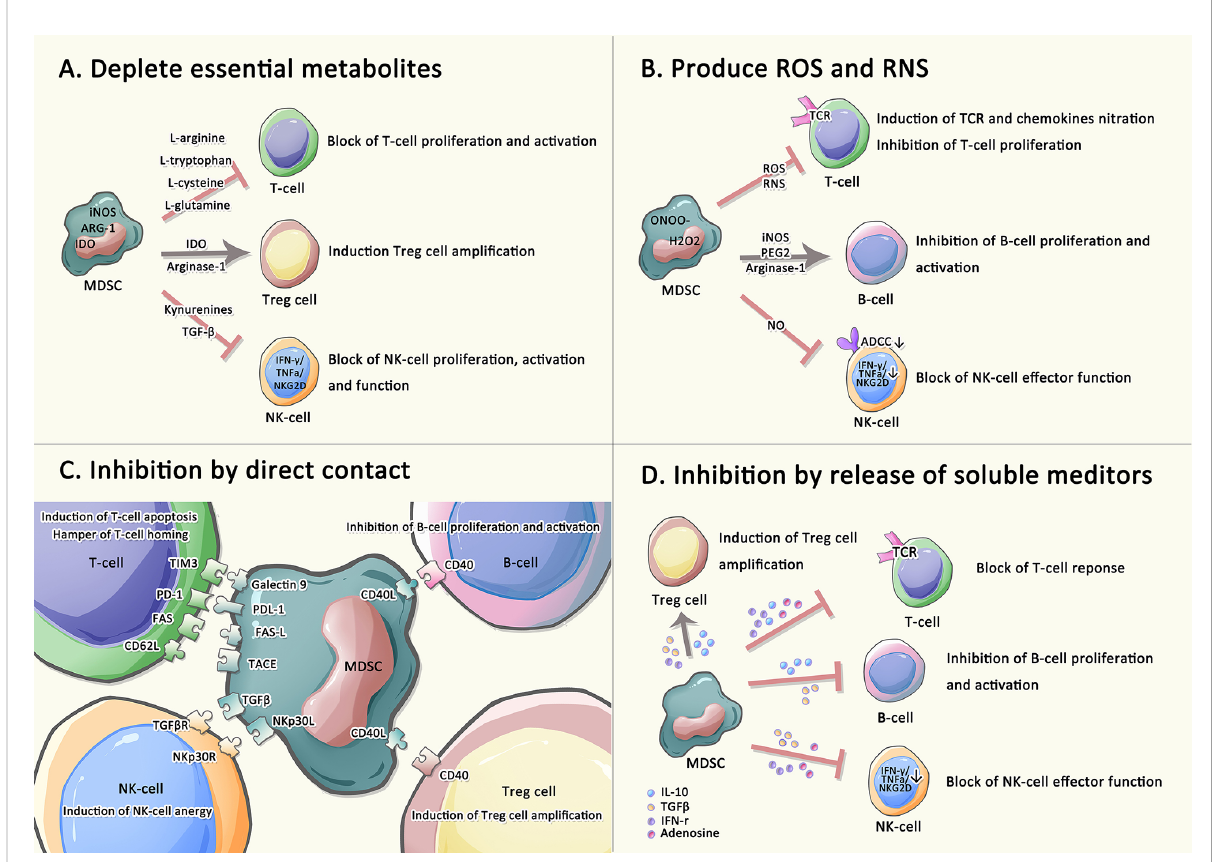
FIGURE 1 Immune regulatory functions of MDSCs on adaptive immune. Immune effector cells are suppressed by MDSCs undergoing the four main strategies: (A) MDSCs depletes amino acids needed for T lymphocyte metabolism. (B) MDSCs generate ROS and RNS. (C) MDSCs suppress T cells, NK cells, and B cells, as well as induce Treg cells ampli fi cation by direct contact. (D) MDSCs involve in releasing numerous soluble factors to induce